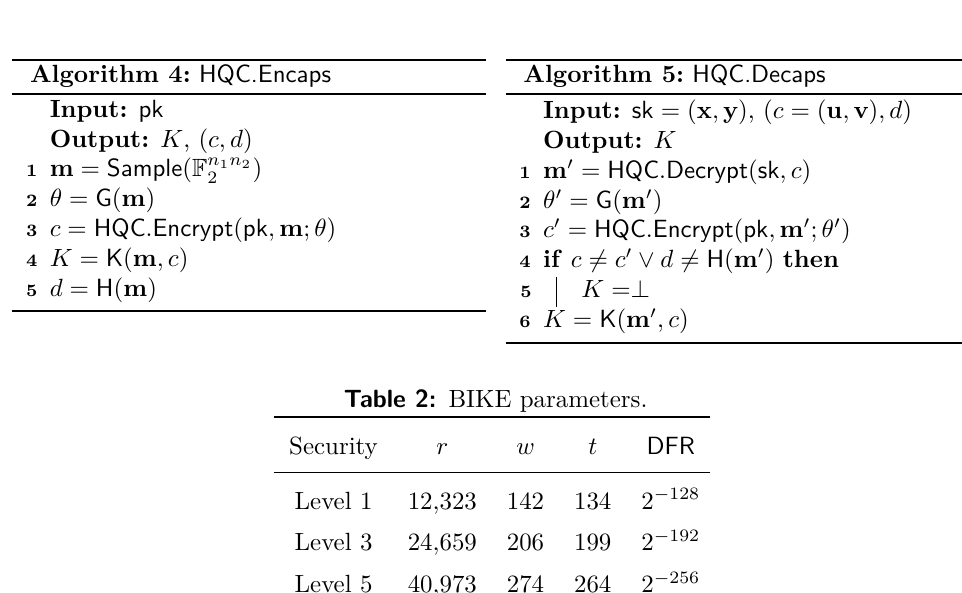
Key-Recovery Timing Attacks Due to Rejection-Sampling in HQC and BIKE